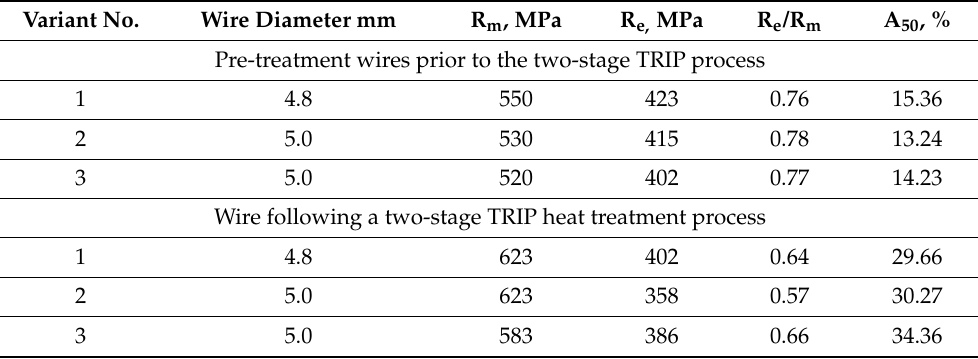
Table 6. Mechanical properties of wires before and after the two-stage heat treatment process, TRIP-type. Variant No. Wire Diameter mm R m , MPa Pre-treatment wires prior to the two-stage TRIP process